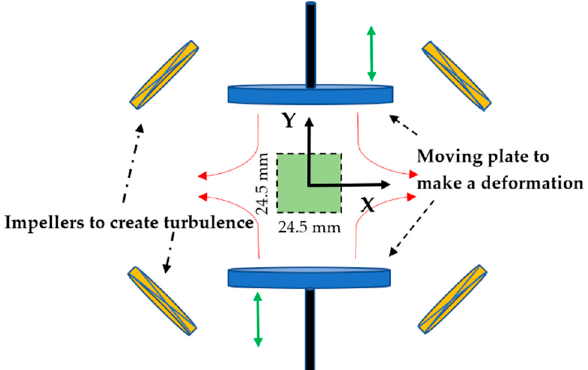
Figure 1. A sketch of the straining mechanism and turbulence generation.